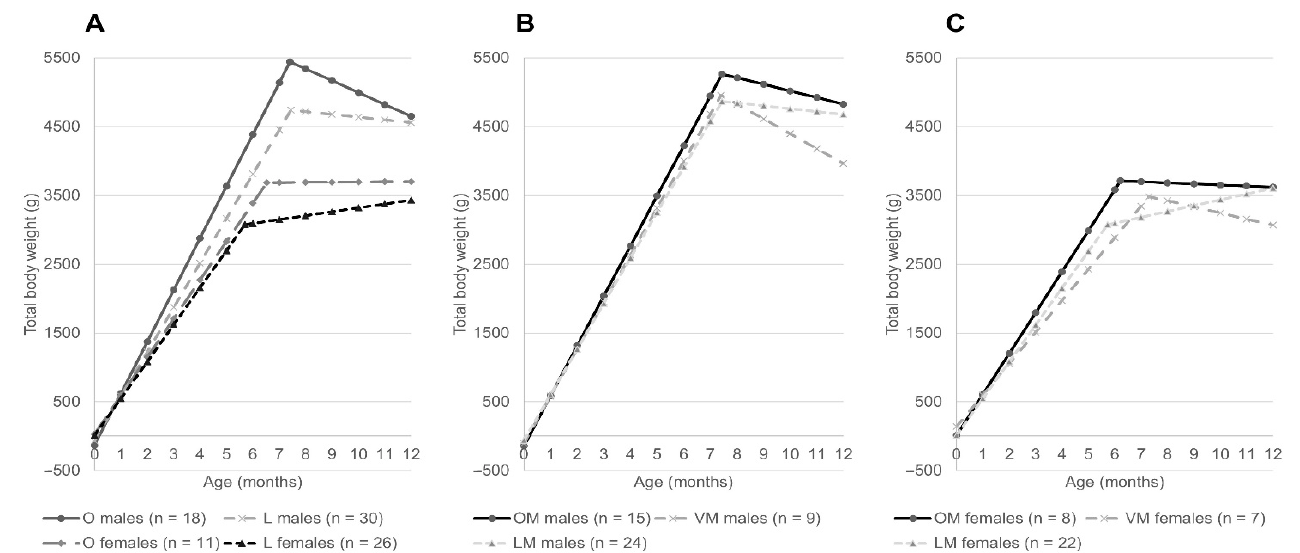
Figure 1. Linear broken-line regressions based on monthly averaged body weight (see Table S1), according to ( A ) sex and body condition score (BCS) at 8 months, ( B ) for males according to maternal phenotype, ( C ) for females according to maternal phenotype (see Table 1 for detailed information on the statistical measures of the respective regression models). Per category, n is given between brackets in the legend. O = kitten BCS ≥ 6 at 8 months, L = kitten BCS < 6 at 8 months, OM = maternal BCS always ≥ 6, VM = maternal BCS differing between < and ≥ 6, LM = maternal BCS always <6.